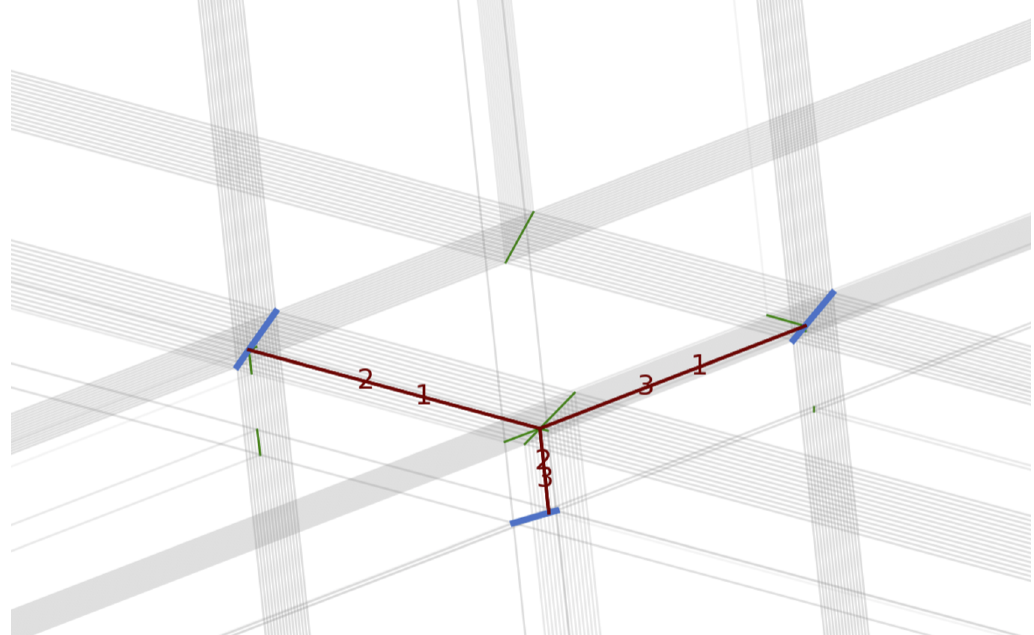
Figure 51 . The picture in R 3 generated by applying our web-finding algorithm to three short link segments. Each of the link segments (blue) emits six strips (gray). When strips of type ij and jk intersect in a segment (green), they can give birth to an additional strip. When a strip of type ij intersects a strip of type ji , the resulting intersection segment is part of a web; in this example there are just three such segments, which make up a single three-string web